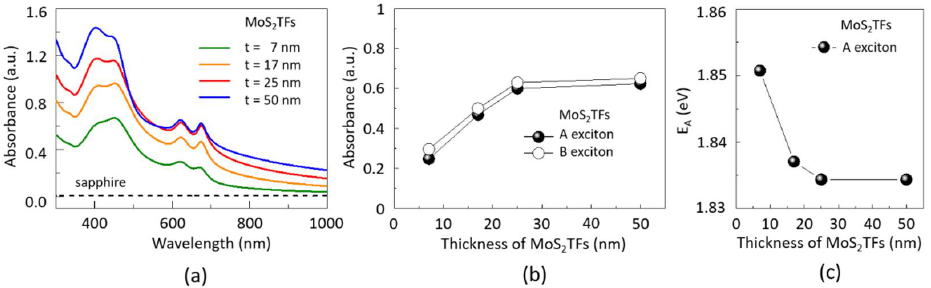
Figure 5. ( a ) UV-Vis-NIR absorption spectra of the MoS2TFs on sapphire as a function of absorbance with thickness. ( b ) Absorbance at the peak position of A and B excitons of the MoS2 TFs as a function of thickness. ( c ) Plot of A exciton energy (EA) from absorbance as a function of MoS2TFs